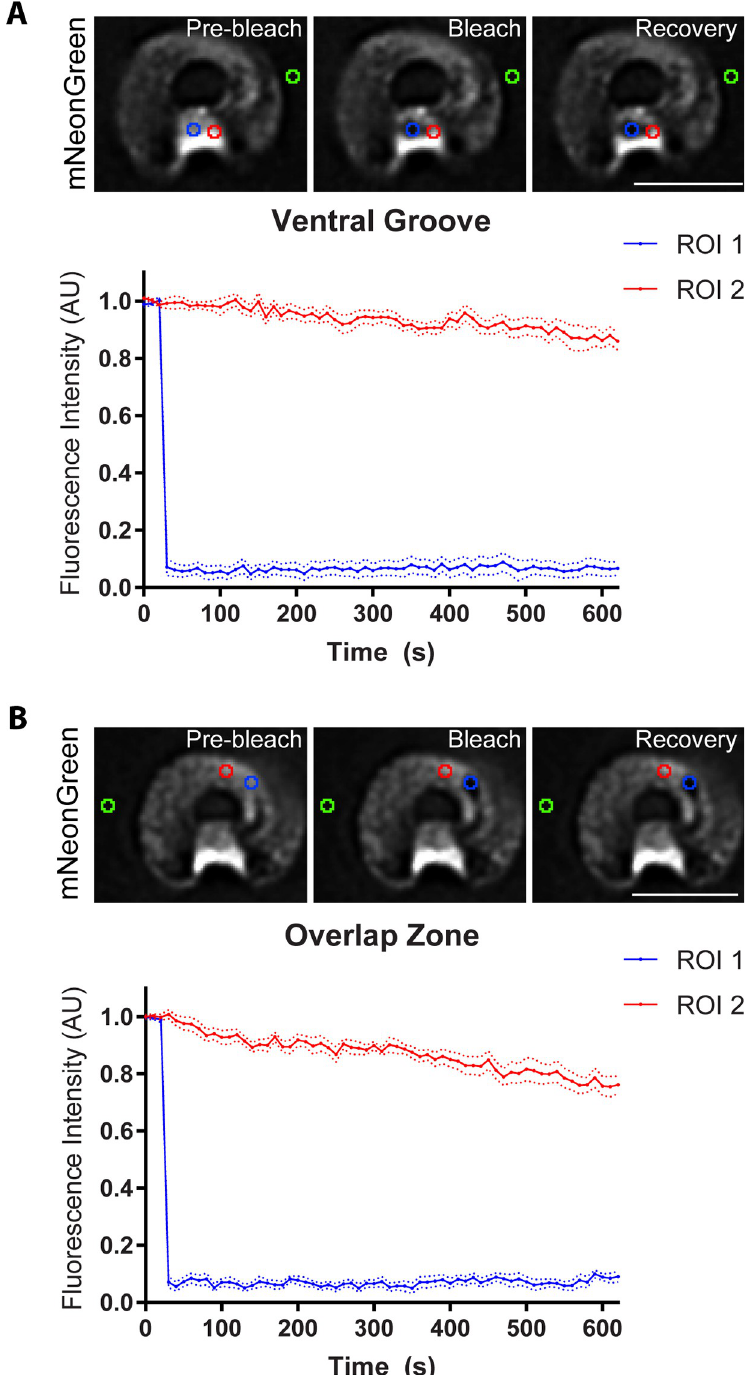
Fig 4. DAAP1 is stably associated with the ventral disc. Fluorescence recovery after-photobleaching (FRAP) in DAAP1-mNeonGreen-cells showed no recovery after 12 minutes for bleached areas in both the ventral groove (A) and overlap zone (B) . Three points of reference were taken, including bleached (ROI1, blue), unbleached (RO2, red), and background (green), and normalized accordingly. Scale bar denotes 5 μ m. N = 10 for each ROI in both A and B.